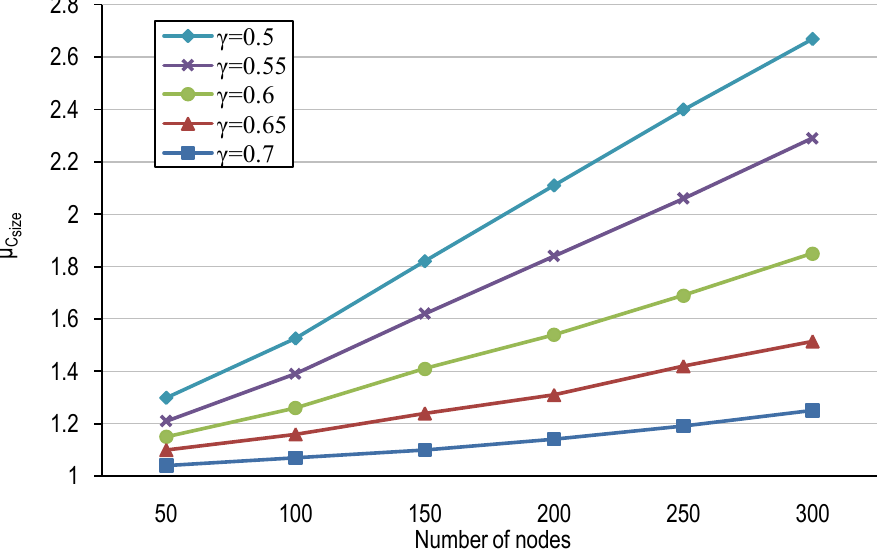
) for different number of nodes and overlapping Csize